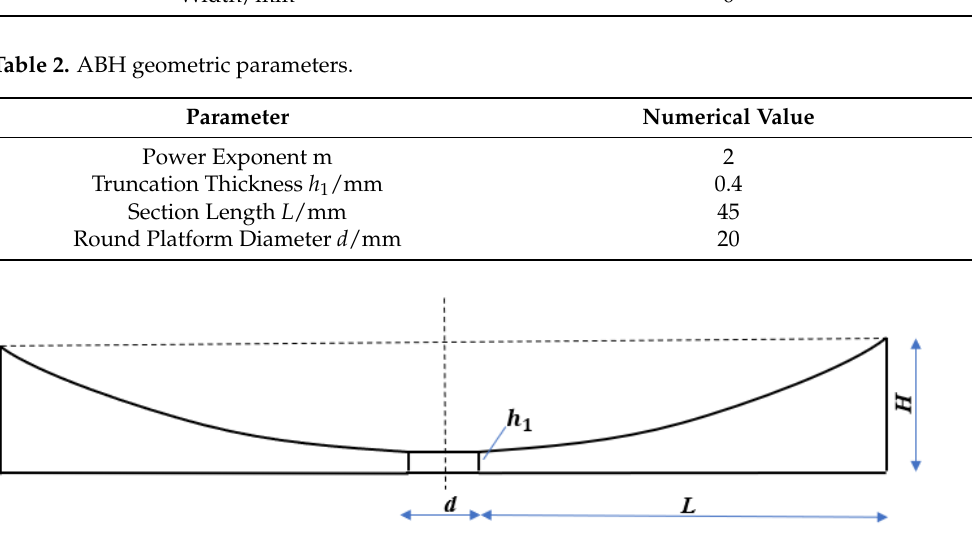
Figure 3. Two-dimensional ABH structure.